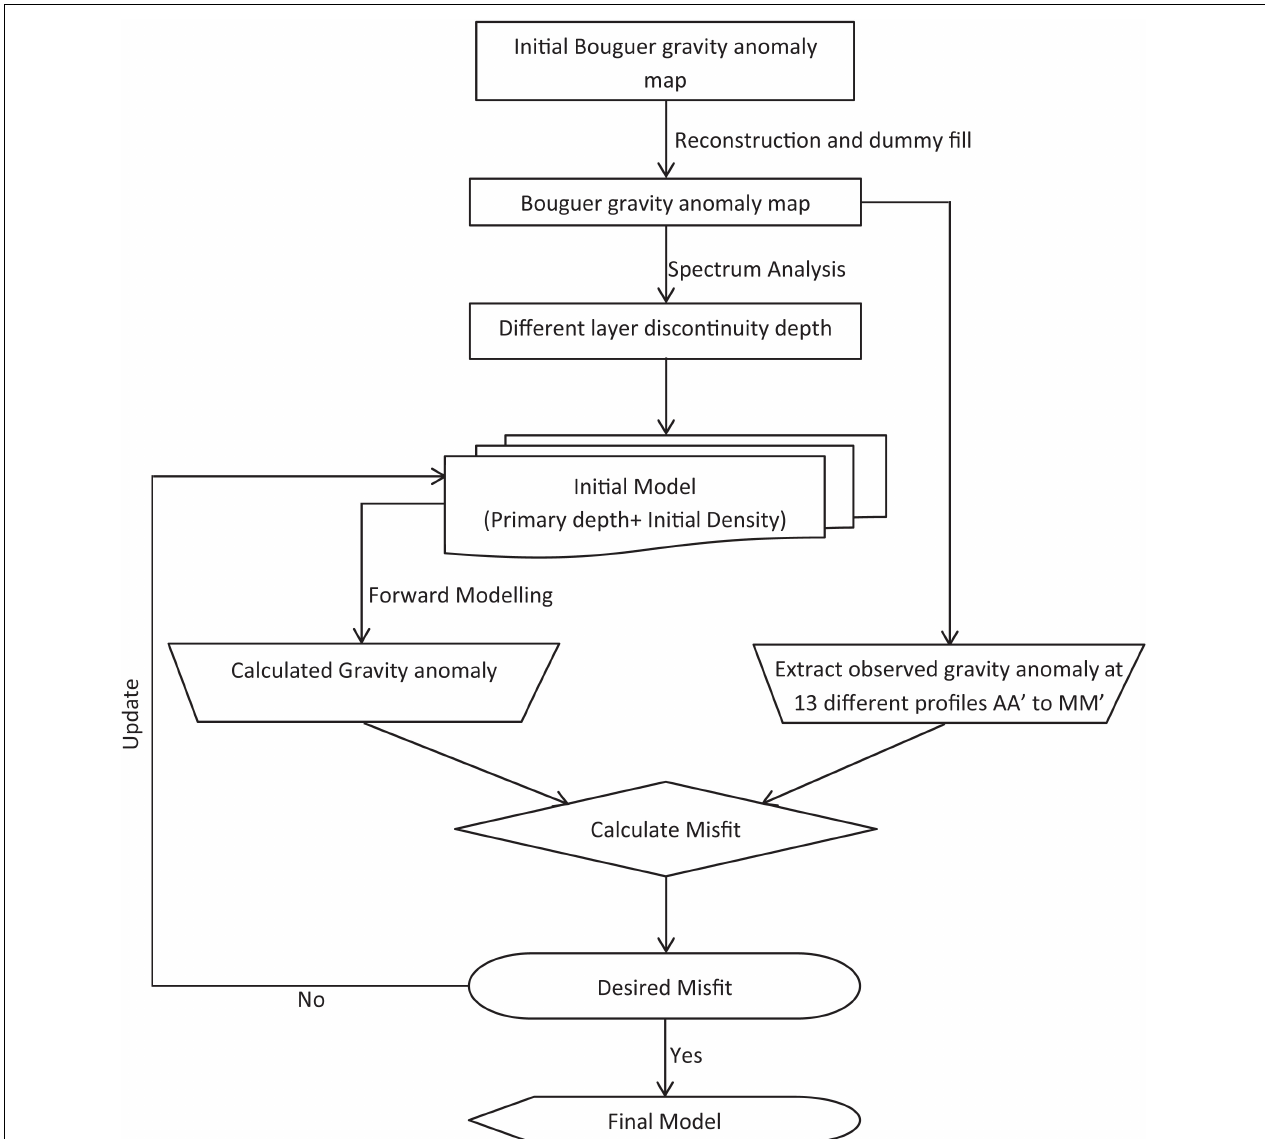
FIGURE 5 | Flowchart showing the various steps followed for the gravity modeling.